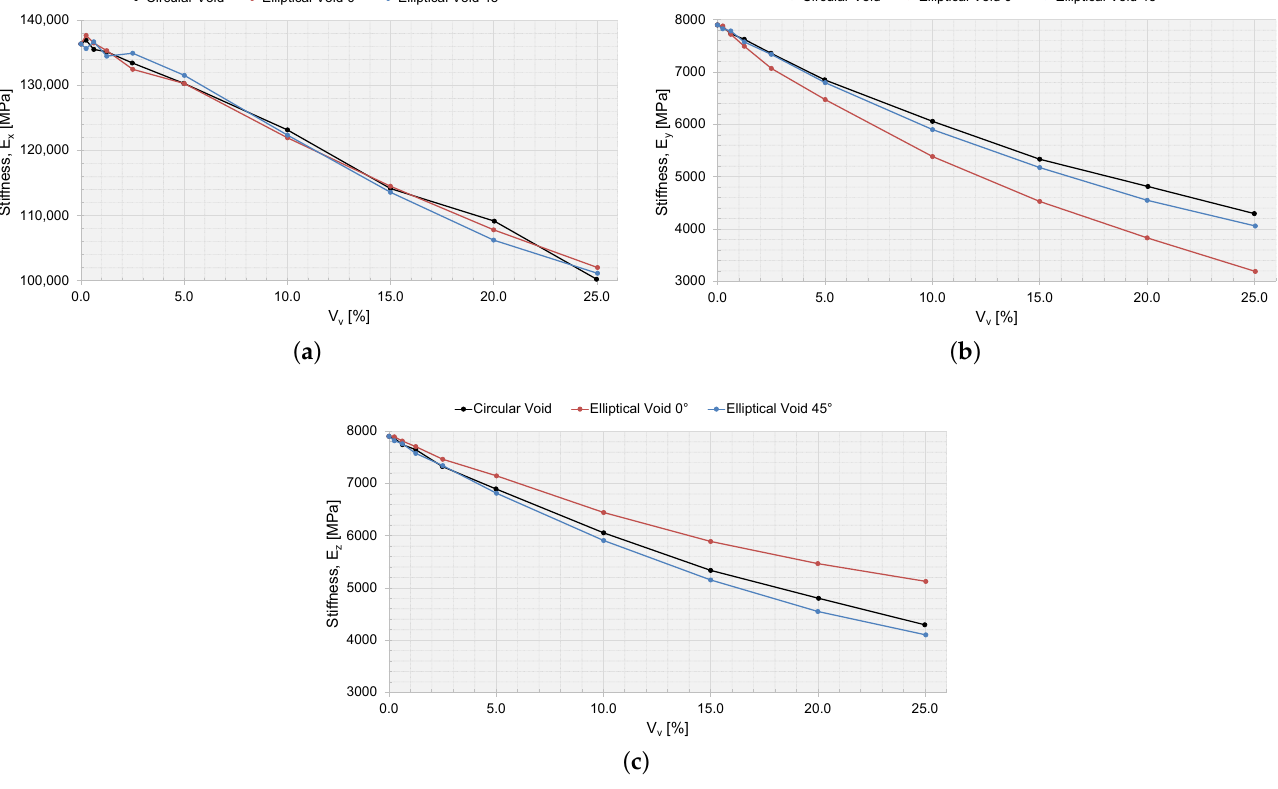
Figure 16. The effective macromechanical properties: ( a ) E x , ( b ) E y , and ( c ) E z , as a function of void area, V v , for a 200 µ m